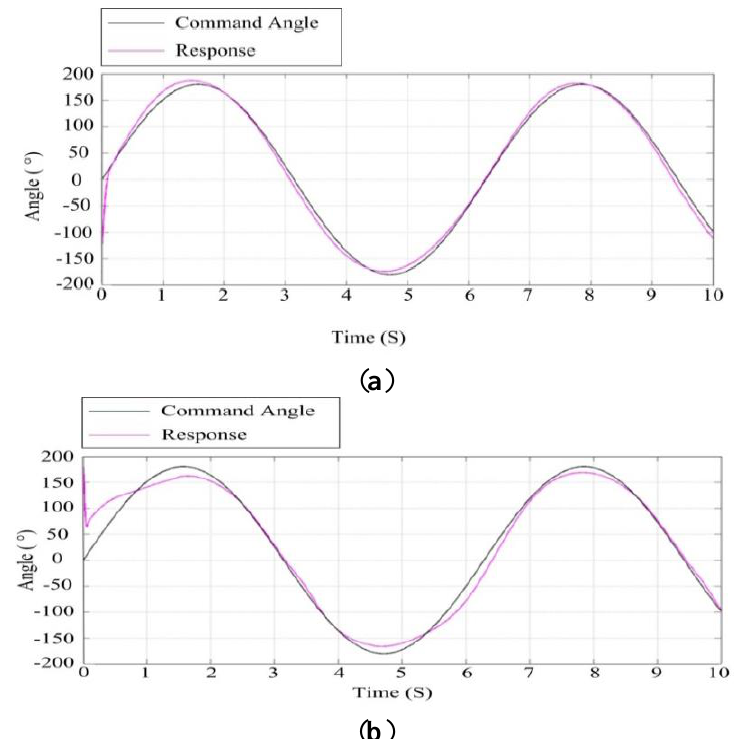
Figure 16. The response curve under 30° sinusoidal angle roll swing of the UA: ( a ) the azimuth gimbal; ( b ) the pitch